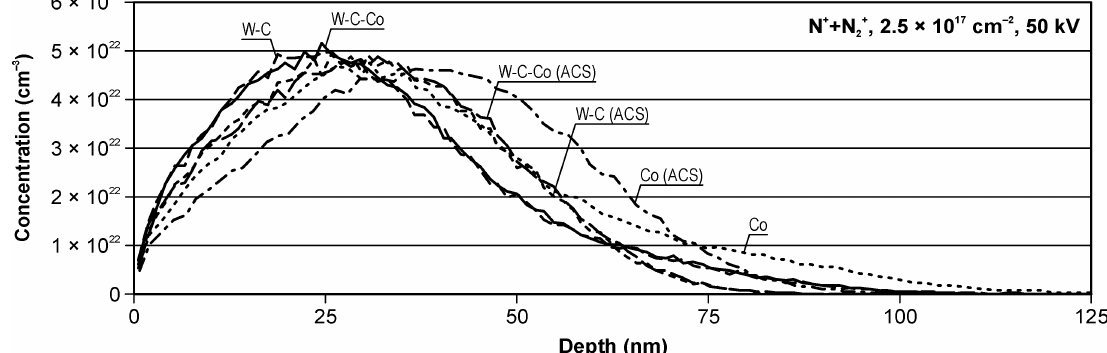
Figure 9. Modelled nitrogen depth profiles in WC-Co.